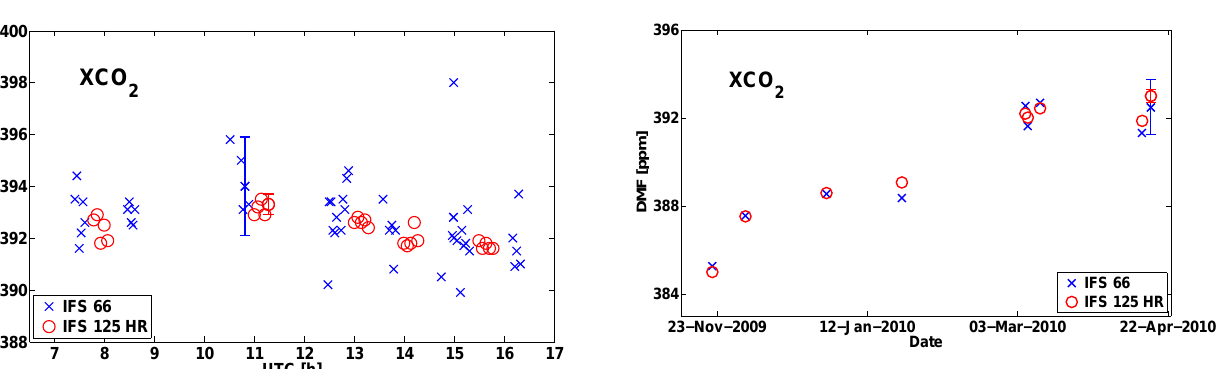
Fig. 4. Individual results for column-average dry-air mole fractions (DMF) of CO 2 , as measured by both instruments for 9 March 2010. 10 interferograms have been averaged for the IFS66 for one data point, and 2 interferograms for the IFS125HR. With typical er- ror bars for single measurements as given by the retrieval software GFIT.